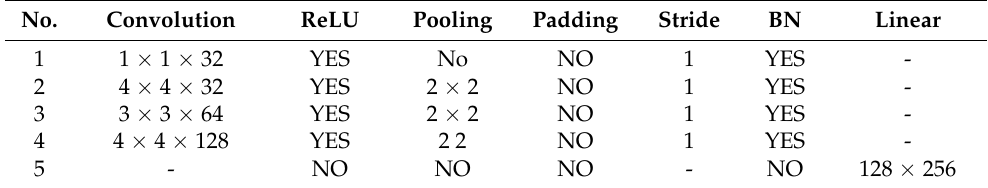
Table 5. Architecture of